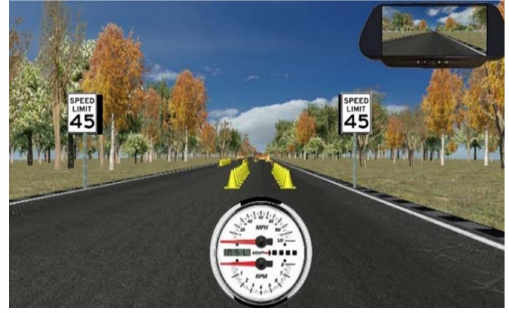
Figure 11. GBL Moose Test (point of view